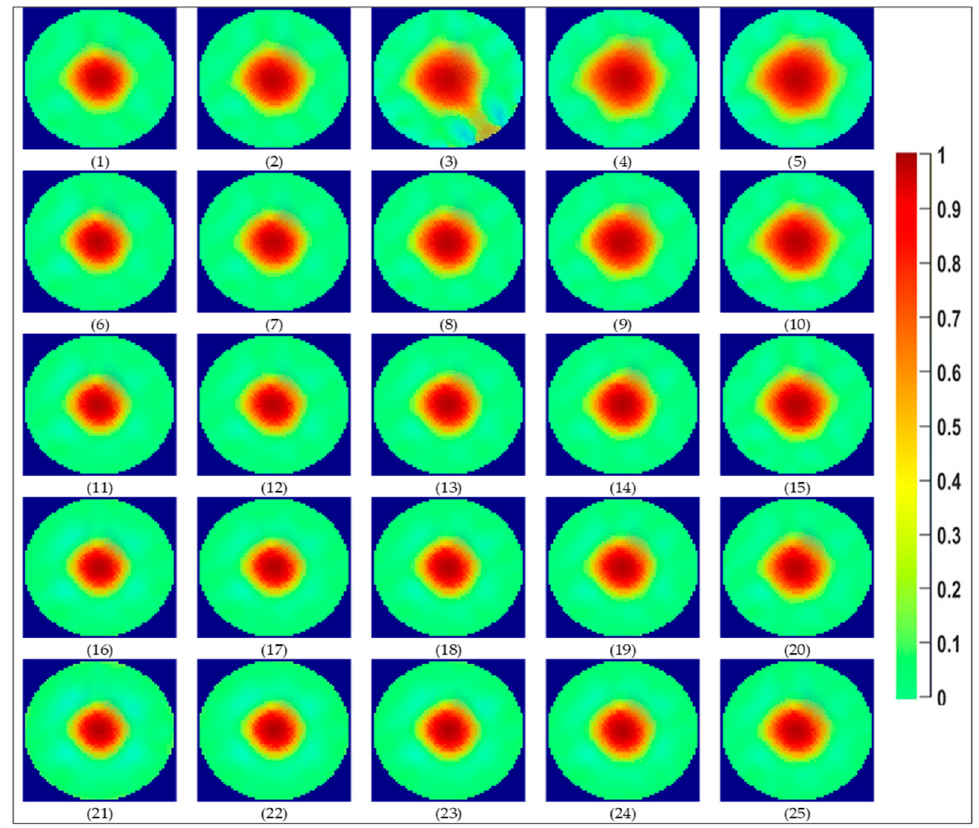
Figure 21. Average projection of the GN reconstructed images obtained for all experimental points. Each row shows images obtained, keeping liquid superficial velocities constant and varying the superficial gas velocities, as it can be guessed from Table A1 in Appendix A.